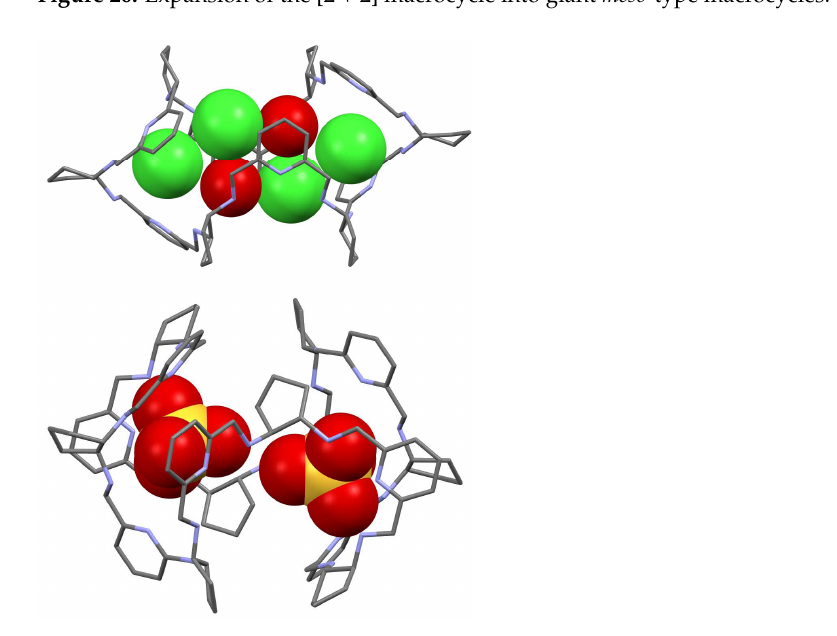
Figure 27. Top—structure of protonated [6 + 6] amine 59 embracing two chloride anions and two water molecules. Bottom—structure of protonated [8 + 8] amine 60 embracing two sulfate anions (chlorides, sulfates and water molecules are shown in spacefill representation, hydrogen atoms are